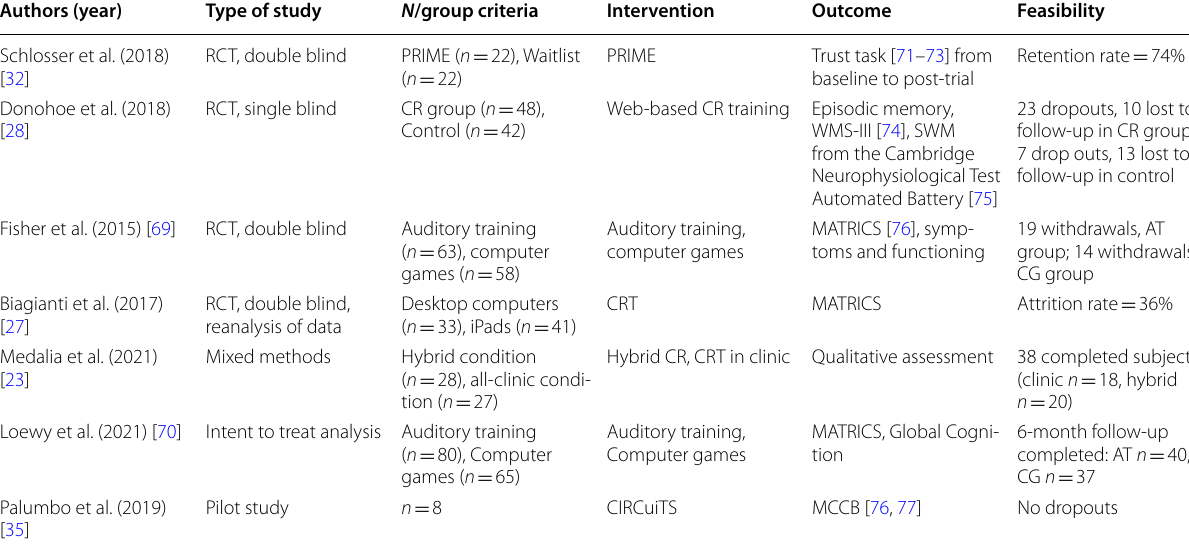
CIRCuiTS Computerized Interactive Remediation of Cognition-Training for Schizophrenia, CR cognitive remediation, CRT cognitive remediation therapy, MATRICS Measurement and Treatment Research to Improve Cognition in Schizophrenia, MCCB MATRICS Consensus Cognitive Battery, PRIME Personalised Real Time Intervention for Motivational Enhancement, RCT randomized controlled trial, SWM Spatial Working Memory, WMS-III Wechsler Memory Scale-3rd